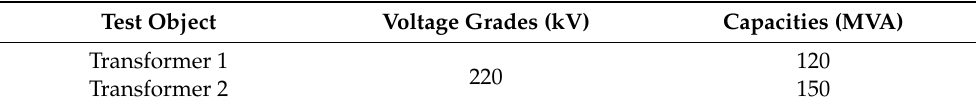
Table 5. Transformer